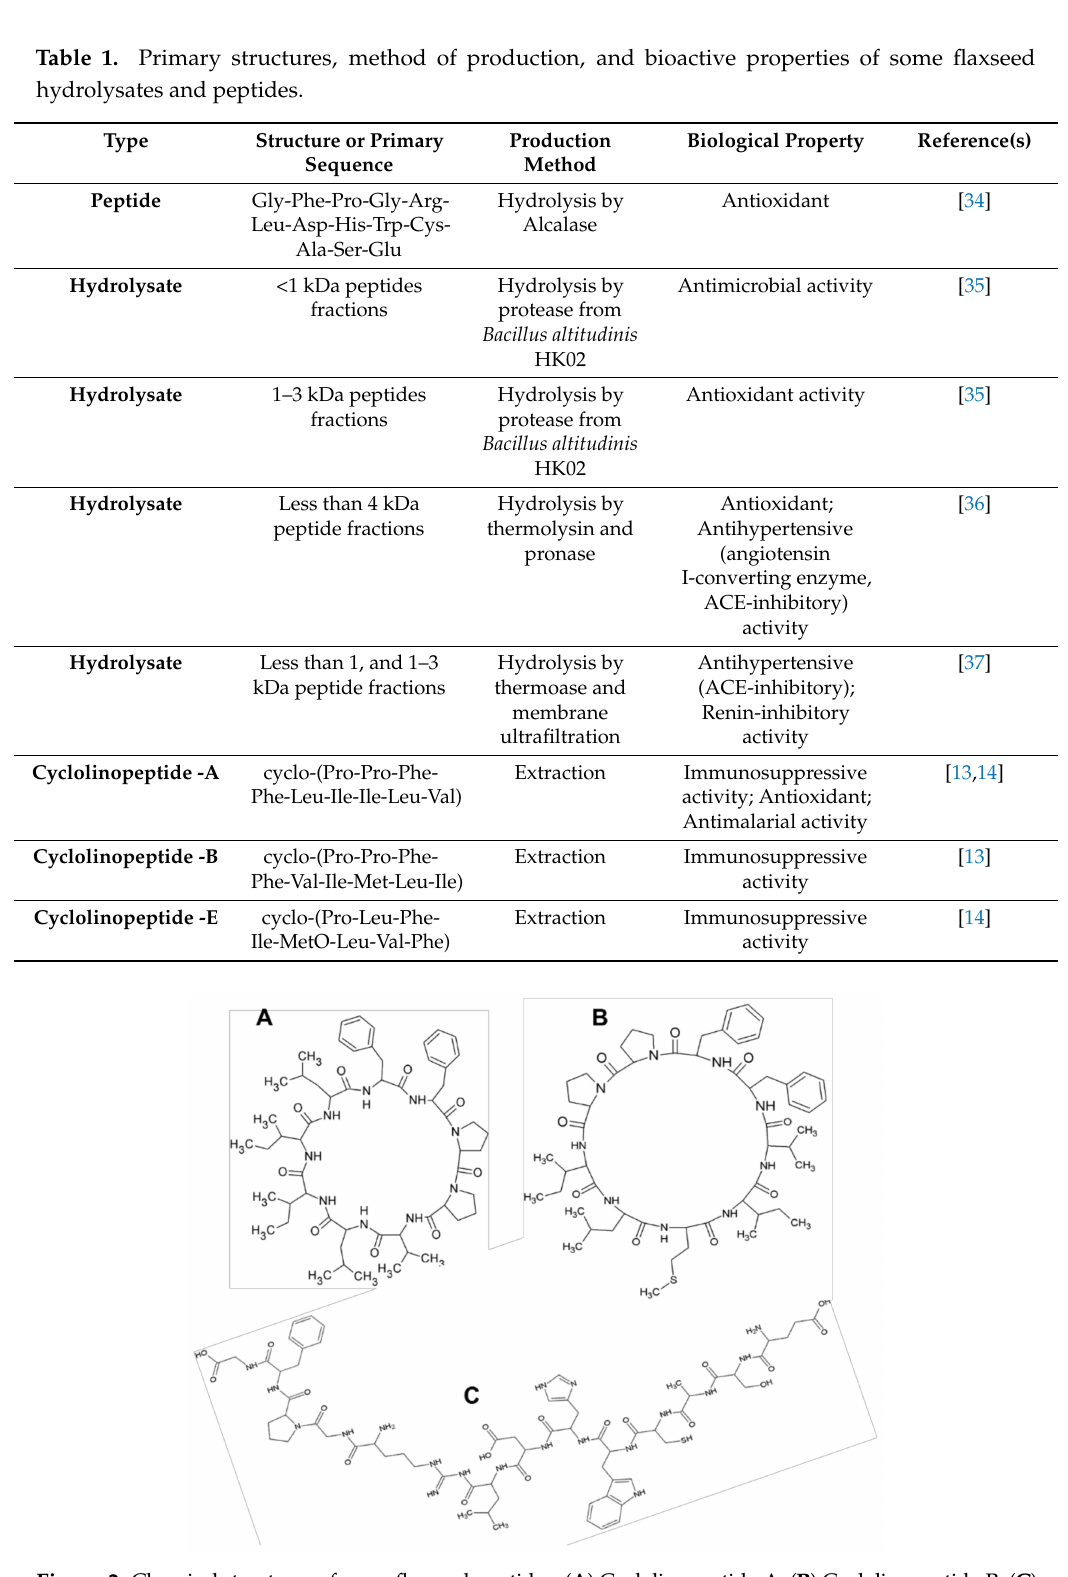
Figure 2. Chemical structures of some flaxseed peptides. ( A ) Cyclolinopeptide-A; ( B ) Cyclolinopeptide-B; ( C ) alcalase-derived antioxidative